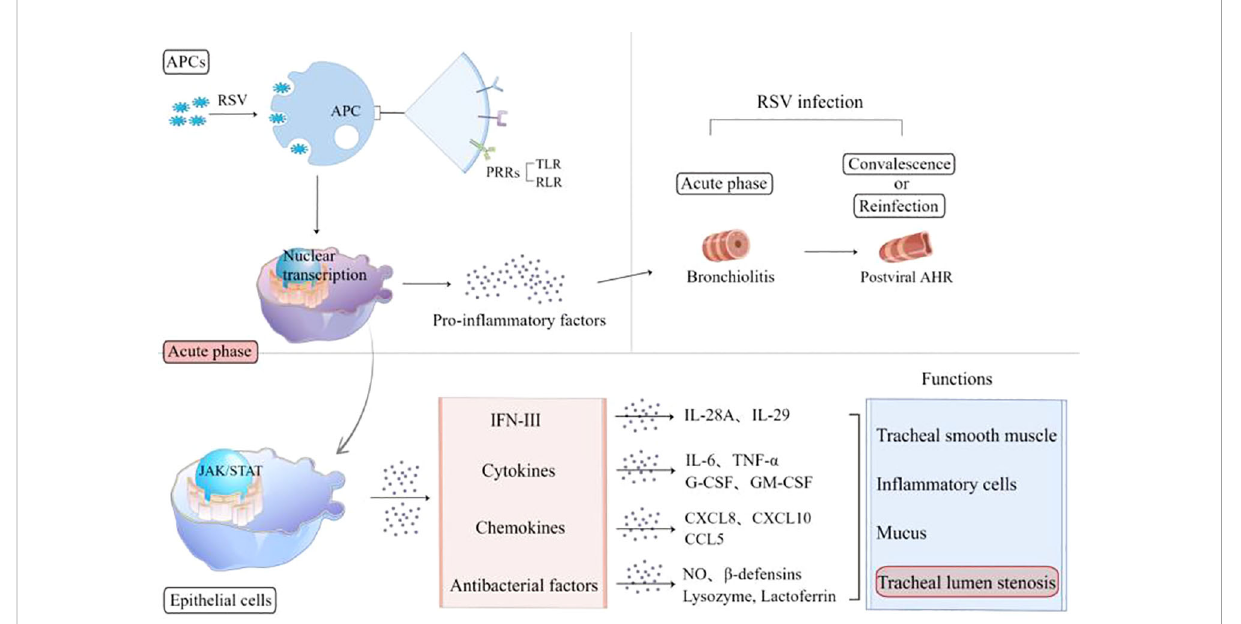
FIGURE 1 RSV activates APCs to express PRRs, including TLR and RLR, and release pro-in fl ammatory factors. In the acute phase, RSV-infected epithelia express interferons, cytokines, chemokines, and antimicrobial factors involved in the airway in fl ammation reaction. The pathological lesions caused by these in fl ammatory mediators experience two stages: bronchiolitis and post-viral AHR. APCs, antigen-presenting cells; RSV, respiratory syncytial virus; PRRs, pattern recognition receptors; TLR, Toll-like receptor; RLR, retinoic acid-inducible gene 1 (RIG-I)-like receptor; AHR, airway hyperresponsiveness; IFN, interferon; IL, interleukin; TNF- a , tumor necrosis factor- a ; G-CSF, granulocyte colony-stimulating factor; GM-CSF, granulocyte – macrophage colony-stimulating factor; NO, nitric